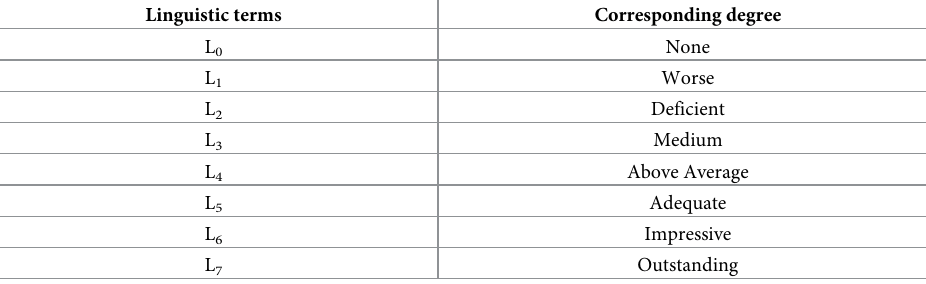
Table 8. Linguistic terms and corresponding degree in